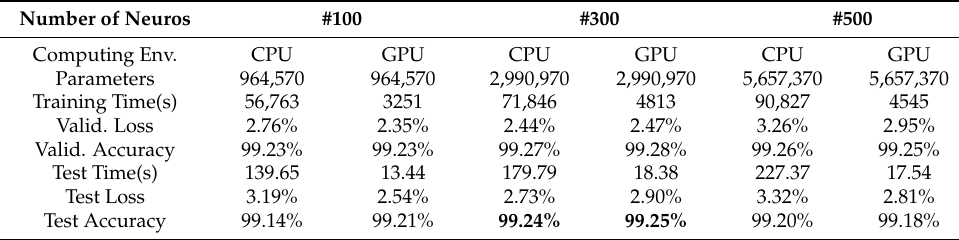
Table 6. Network performance of the two-channel CNN concatenated with a single-layer BiLSTM ar- chitecture. Number of Neuros #100 #300 Computing